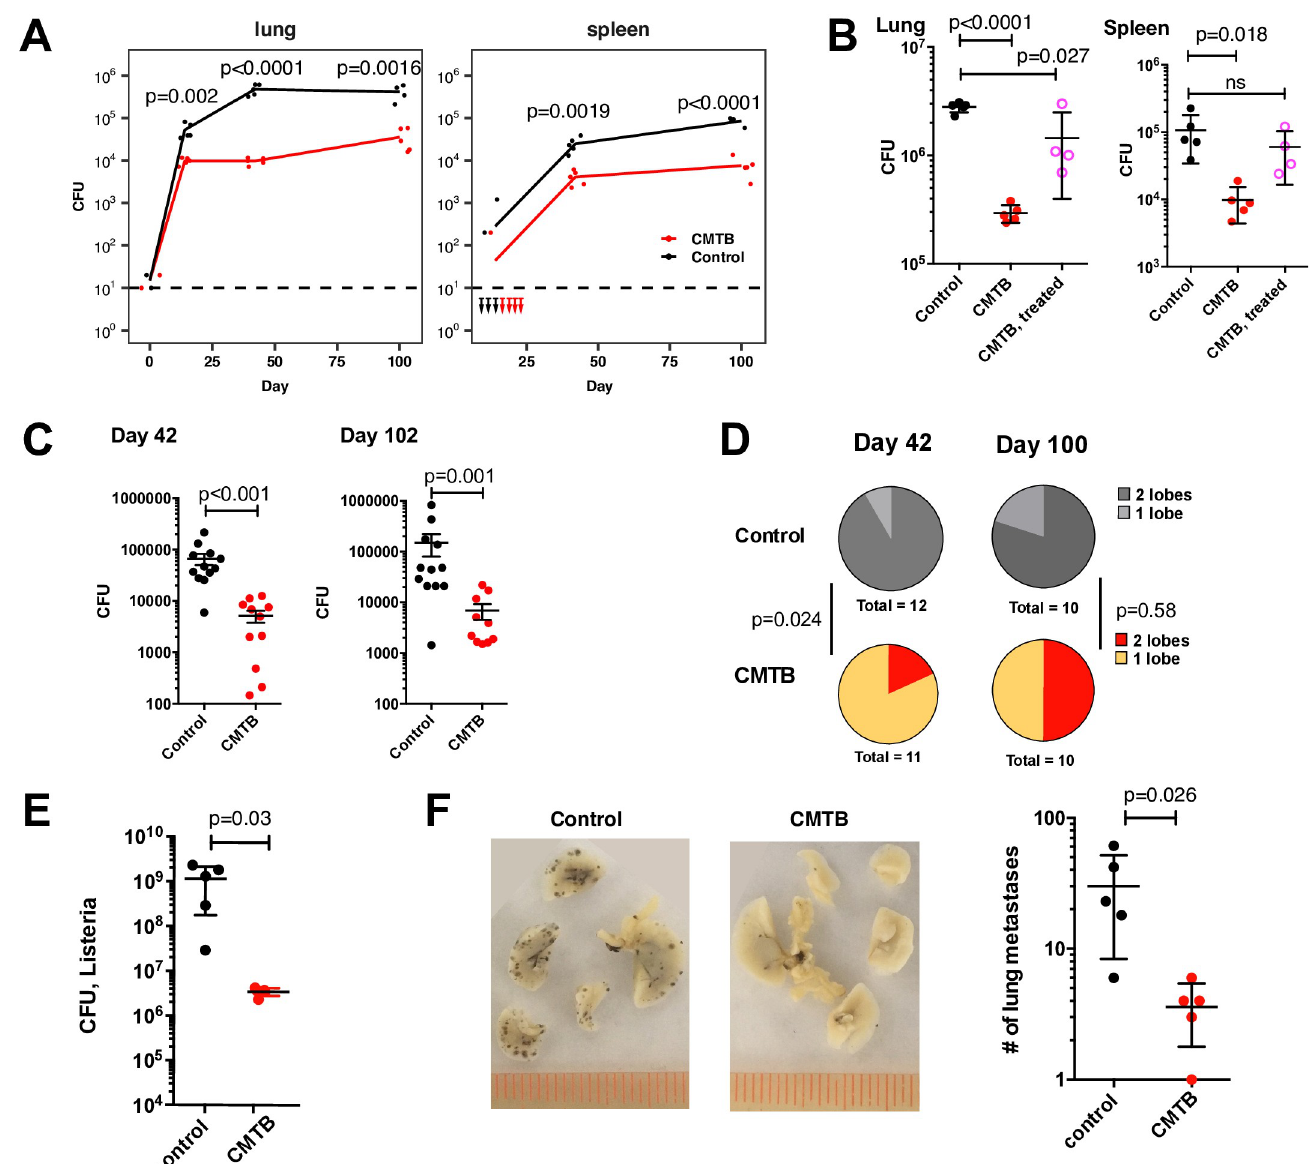
Fig 2. Contained TB infection provides sustained protection against aerosol challenge with Mtb and heterologous challenges. ( A ) 8 weeks after the establishment of CMTB, mice were challenged with 50–100 CFU of Kanamycin-resistant H37Rv via aerosol. Bacterial burdens in the lungs and spleen were measured by CFU at days 14, 42 and 100 following aerosol infection using plates containing Kanamycin. (Mtb was never detected in the spleen of CMTB mice at day 14.) Plot shows representative data from one of two independent experiments (n = 4–5 mice per group). Statistical significance was determined by Student’s t - test. ( B ) CMTB was established and after 2 weeks CMTB and control mice were treated for 6 weeks with Isoniazid and Rifampicin. Mice were challenged via aerosol with 50–100 CFU of H37Rv Mtb and bacterial burden in the lung and spleen measured at 6 weeks. Data are representative of 2 independent experiments with 4–5 mice per group. Error bars depict mean and SD. Statistical significance was determined by Student’s t -test. ( C ) CMTB and control mice (20 per group) were infected with an average of 1 CFU of Mtb H37Rv via aerosol. Bacterial burdens in the lung were measured by CFU. Data are representative of two independent experiments. Mice with no detectable bacteria were omitted from the plot. Statistical significance was determined using the Mann-Whitney test. Error bars depict the mean and SEM. ( D ) Fractions of control and CMTB mice with detectable bacteria in one or two lobes of the lung in the experiments shown in ( C ). Uninfected mice are excluded from the plot. Significance was assessed using the exact test for the difference of means in two Poisson distributions. ( E ) CMTB and control mice were challenged i.v. with 10 5 CFU of Listeria monocytogenes and bacterial burden in the spleen measured 48 hours following infection by CFU. Statistical significance was determined by Student’s t -test. Data are representative of two independent experiments with 4–5 mice per condition. ( F ) CMTB and control mice were challenged i.v. with 1x10 6 B16-F10 melanoma cells. Disease burden was quantified by counting the number of metastases visible in the lung 10 days following challenge (left panel, black spots). Data are representative data of three independent experiments with 4–5 mice per group. Significance was assessed by Student’s t -Test. Error bars depict the mean and